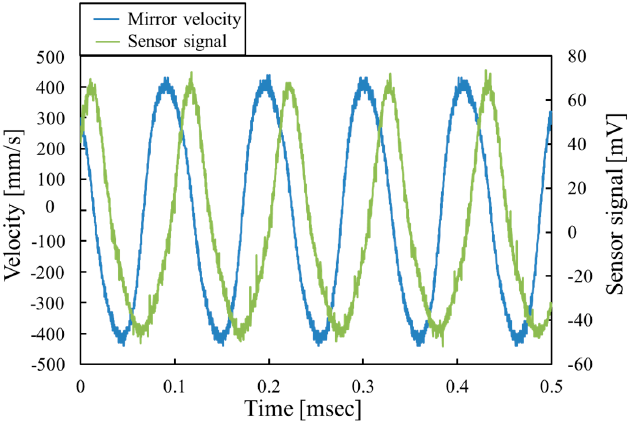
Figure 11. Velocity of the varifocal mirror at the center and the piezoresistor signal as a function of